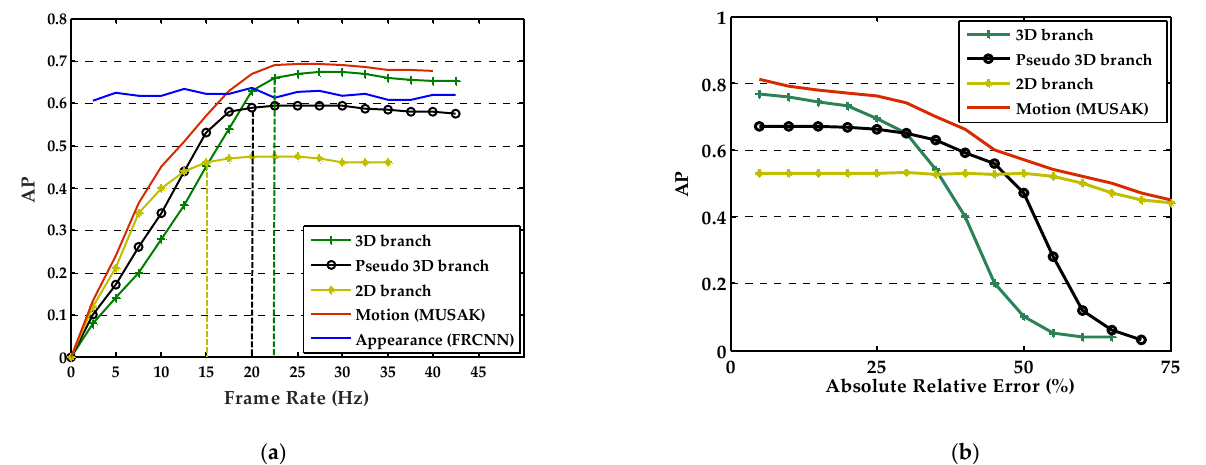
Figure 13. The impact of temporal-spatial resolution. ( a ) Impact of Frame Rate. ( b ) Impact of Absolute Relative Error.